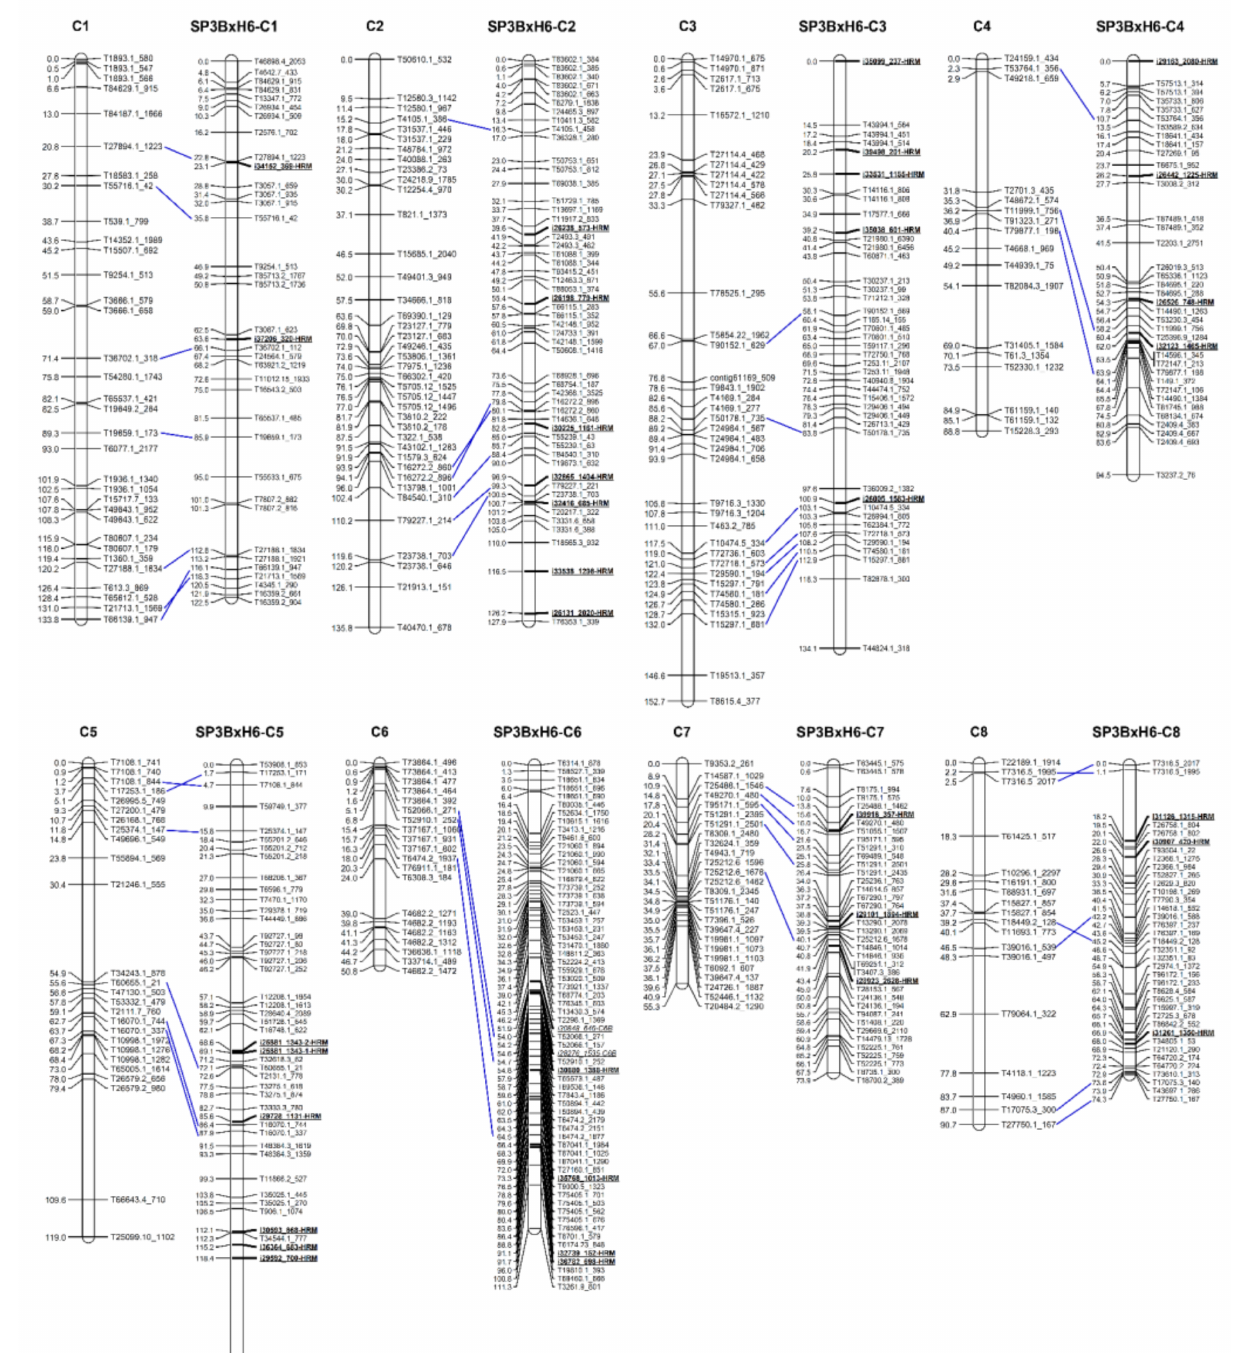
Figure 3. Comparison of two onion genetic linkage maps, the 16P118 × Sweet Green map constructed in this study and the SP3B × H6 map developed by Choi et al. [27]. Bar left or right number, map position (centi Morgan, cM); bar left or right name, marker name; dotted blue line, connection between the same transcript-based